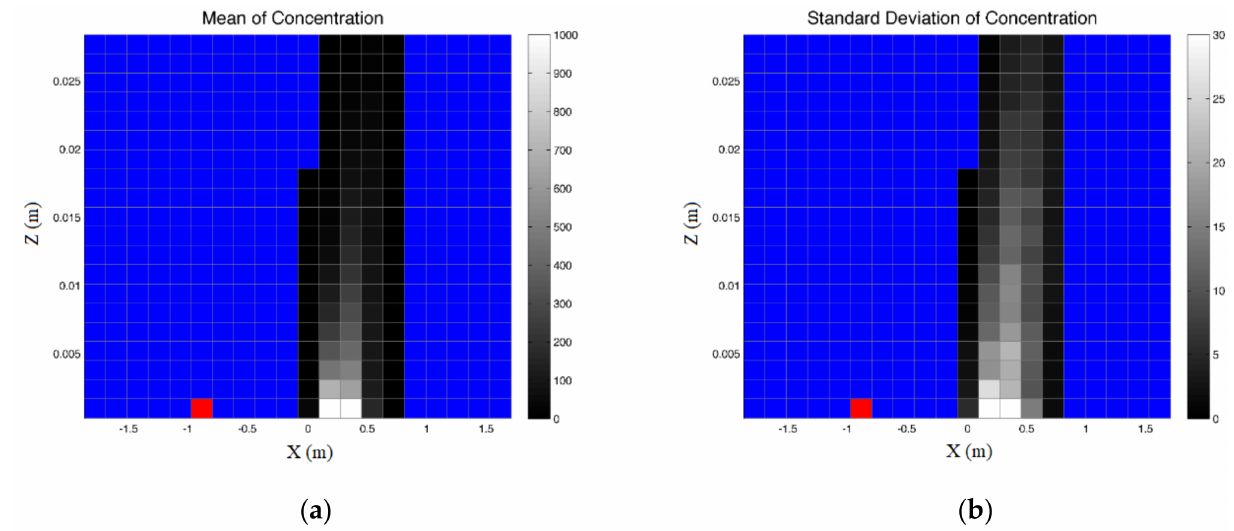
Figure 18. ( a ) Ensemble mean and ( b ) standard deviation where particles from ( − 0.9, 0), a non-probable